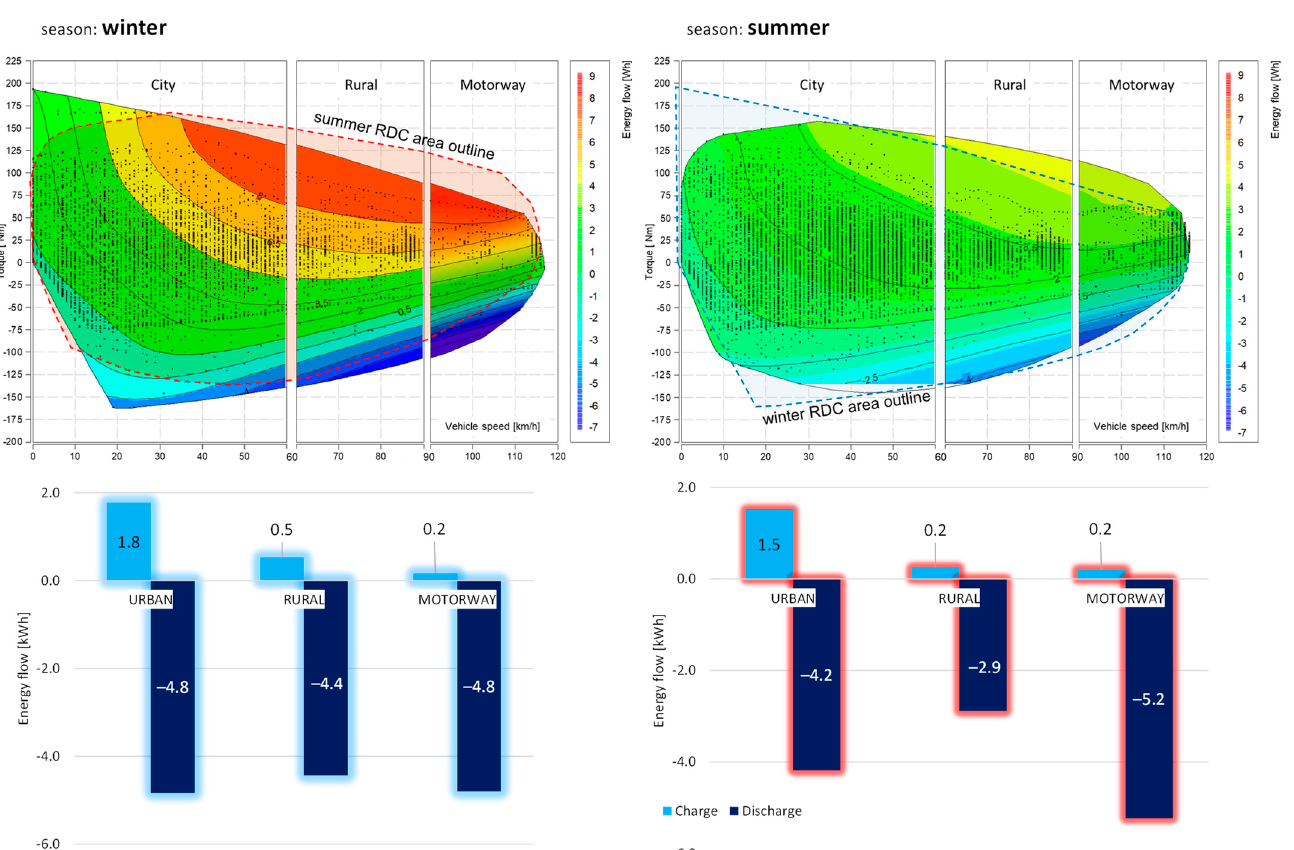
Figure 21. Power consumption of the drive expressed on the diagram of usable parameters for various speed sections.